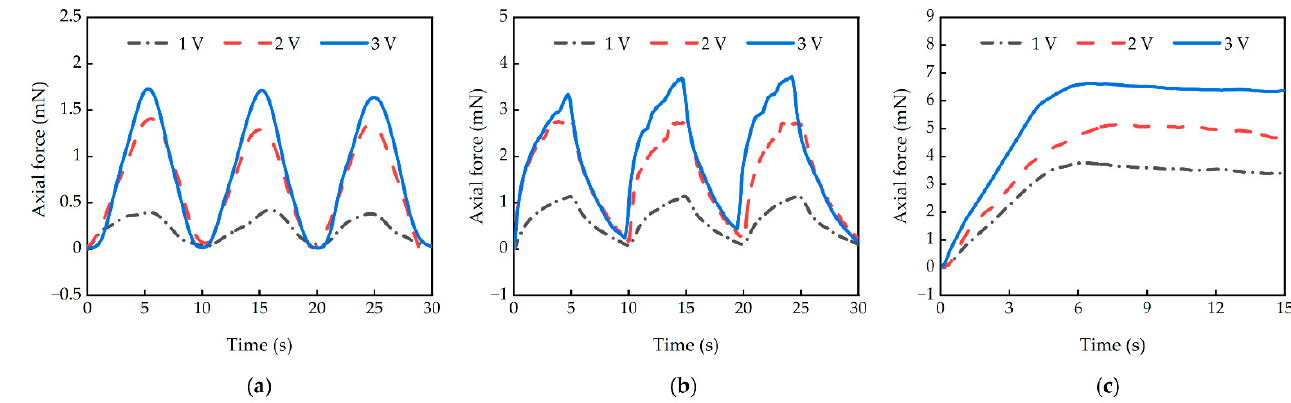
Figure 8. Axial forces of the helical IPMC actuator under different signals with different amplitudes: ( a ) sinusoidal signal; ( b ) square wave signal; ( c ) DC signal.